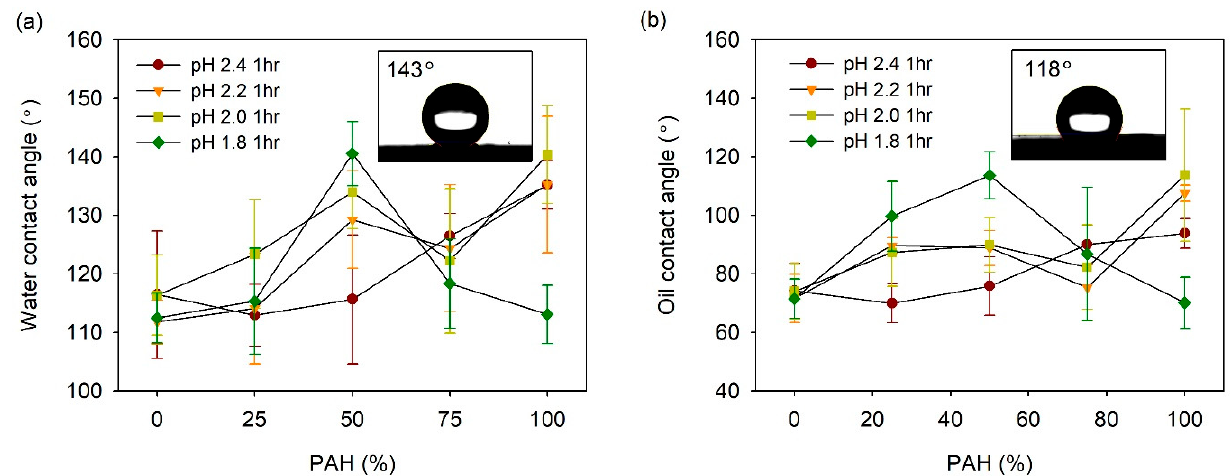
Figure 7. ( a ) WCA and ( b ) OCA of acid-treated LbL films coated with TCPFS. Inset figures in Figure 7a,b show water and oil droplet on 50% PAH film treated at pH 1.8, respectively.